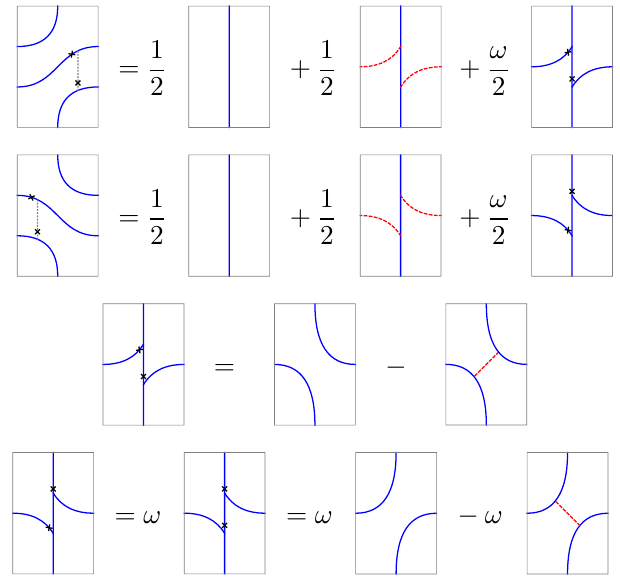
Figure 38 . Derivation of the spin selection rules for the R C ( S 3 ) fusion ring. We apply the H- junction crossing relations to the T 2 and T (cid:0) 2 transformations of a temporal Y line. The blue and red-dashed lines are used to denote the Y and X lines respectively. The black-dotted lines representing the trivial lines, and the crosses marking the ordering at trivial junctions are in fact unnecessary. We include them to make explicit the particular crossing kernels that are applied here. However, it is important to keep track of the marks on the Y Y Y junctions due to the nontrivial cyclic permutation map acting on V Y;Y;Y